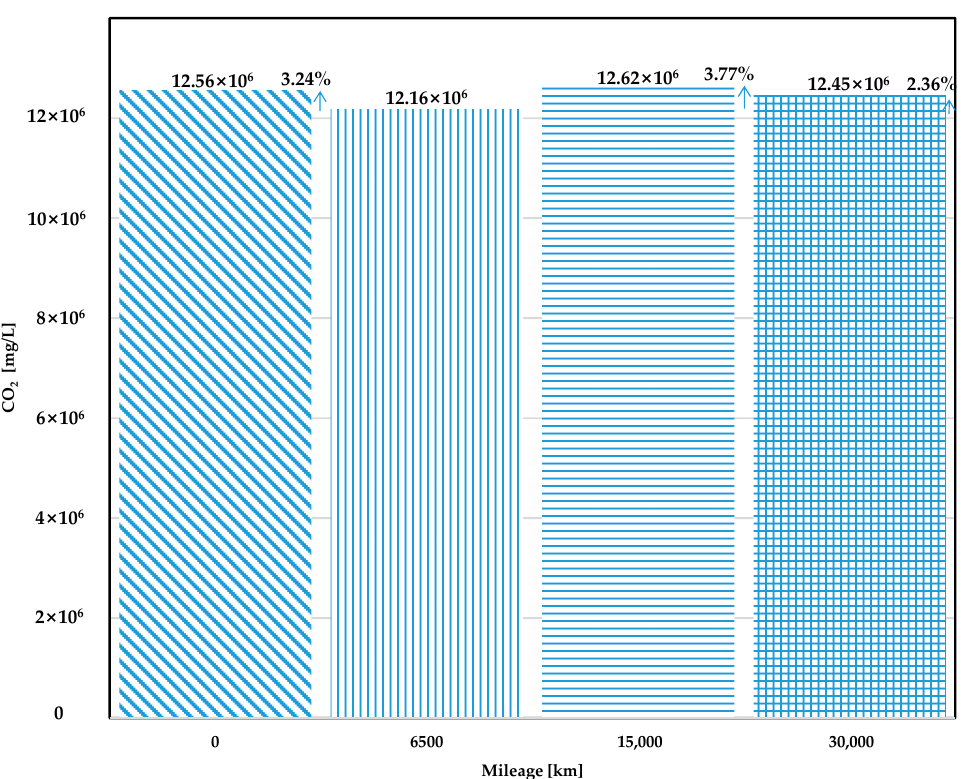
Figure 6. Total CO 2 emissions measured during the FTP-75 driving cycle according to each mileage.